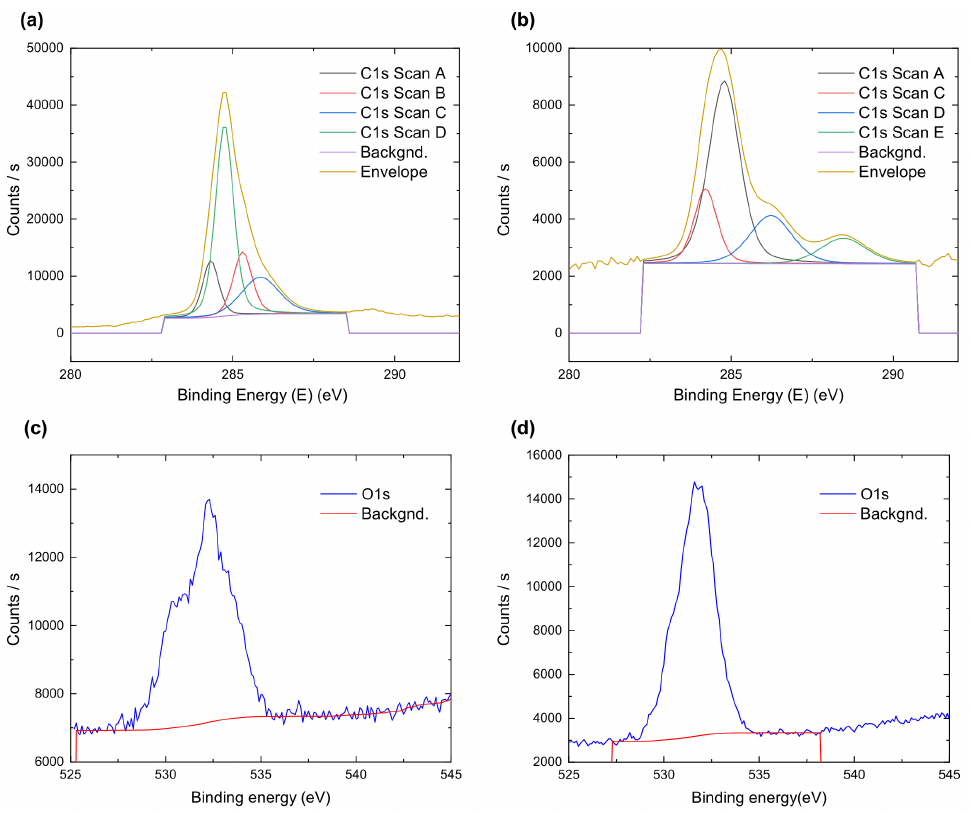
Figure 5. XPS spectra of ( a ) carbon peaks before sonication, ( b ) carbon peaks after sonication, ( c ) oxygen peaks before sonication, and ( d ) oxygen peaks after